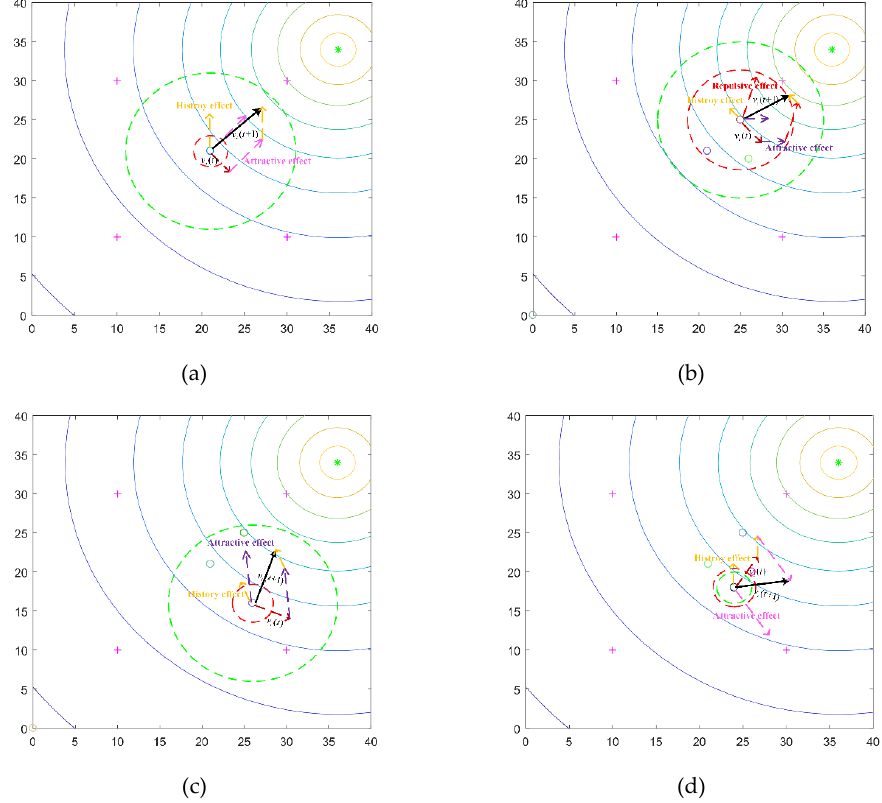
Figure 2. The velocity updating process of a robot in swarm robotic pedestrian behavior (SRPB). ( a ) robot is alone; ( b ) repulsive effect acts as the thrust; ( c ) attractive effect; ( d ) separation.